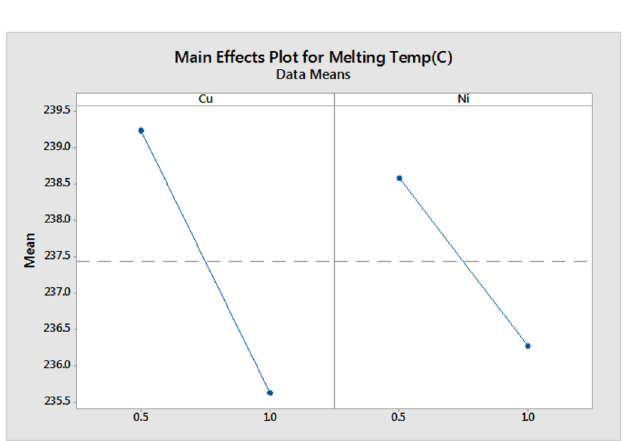
Fig. 1. Mean effects plot for melting temperature.